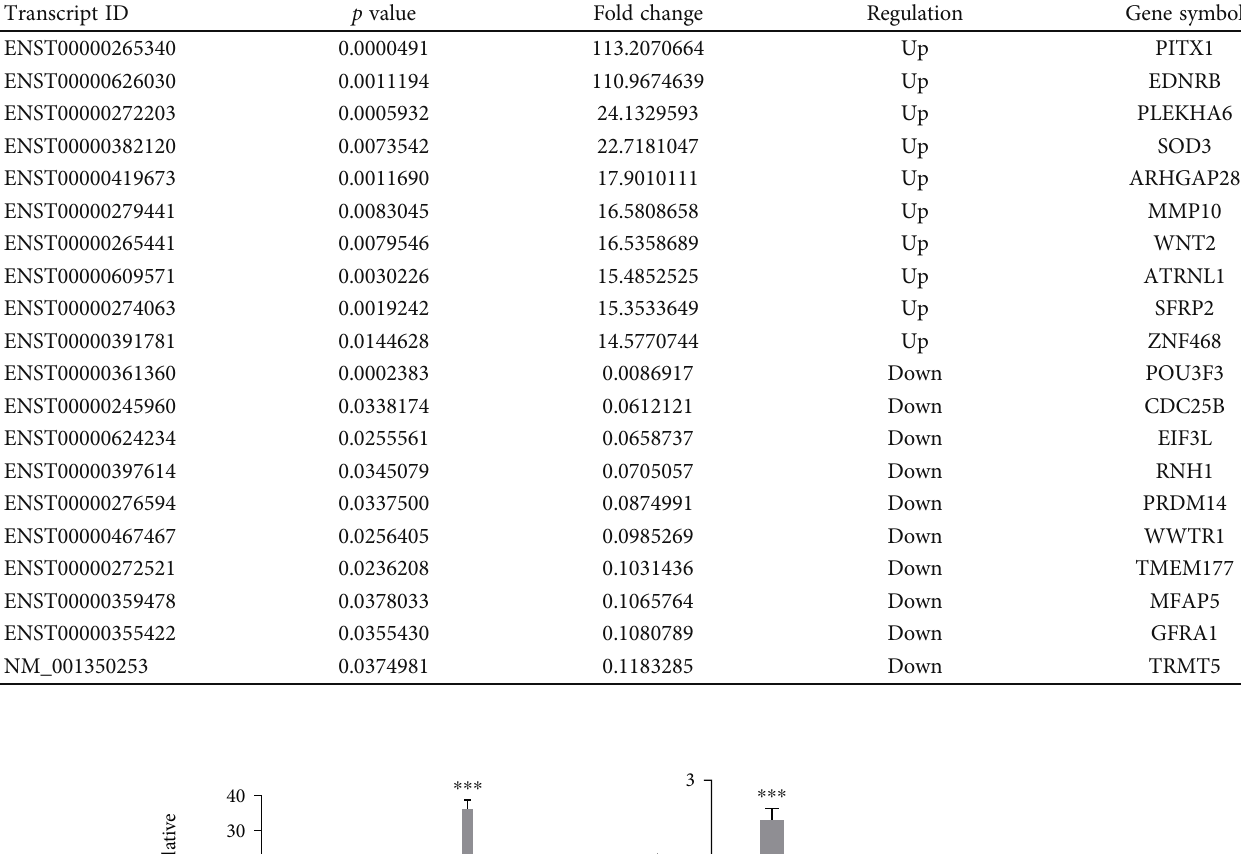
Table 3: The 20 most di ff erentially methylated mRNAs in pPDLSCs under SMS.